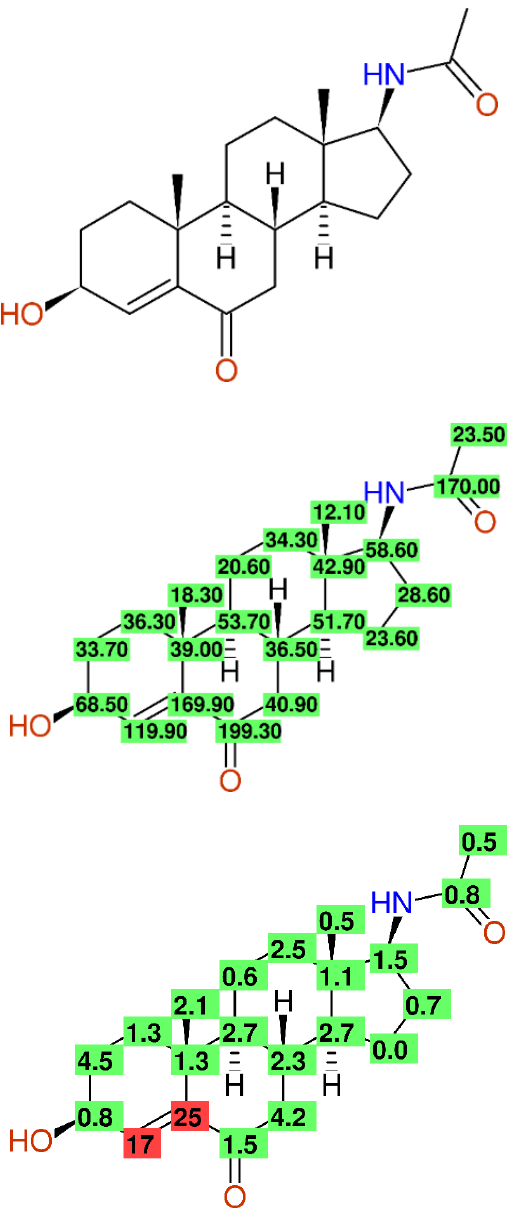
Figure 12. 3ß-Hydroxy-17-acetamidoandrost-4-en-6-one as published in [56] for compound 8 ( left ), together with the differences between the experimental and predicted chemical shift values. The automatic structure revision proposes the 6-hydroxy-3-one derivative ( right ) leading to a much better, but not perfect coincidence, with the experimental data.